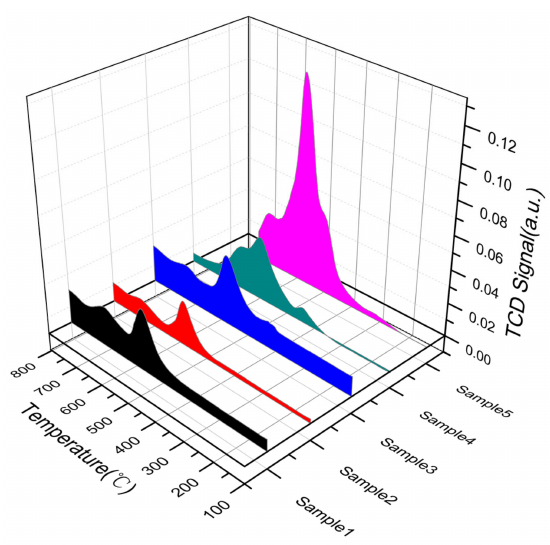
Figure 4. Analysis of the redox capability of rare earth concentrates subjected to di ff erent